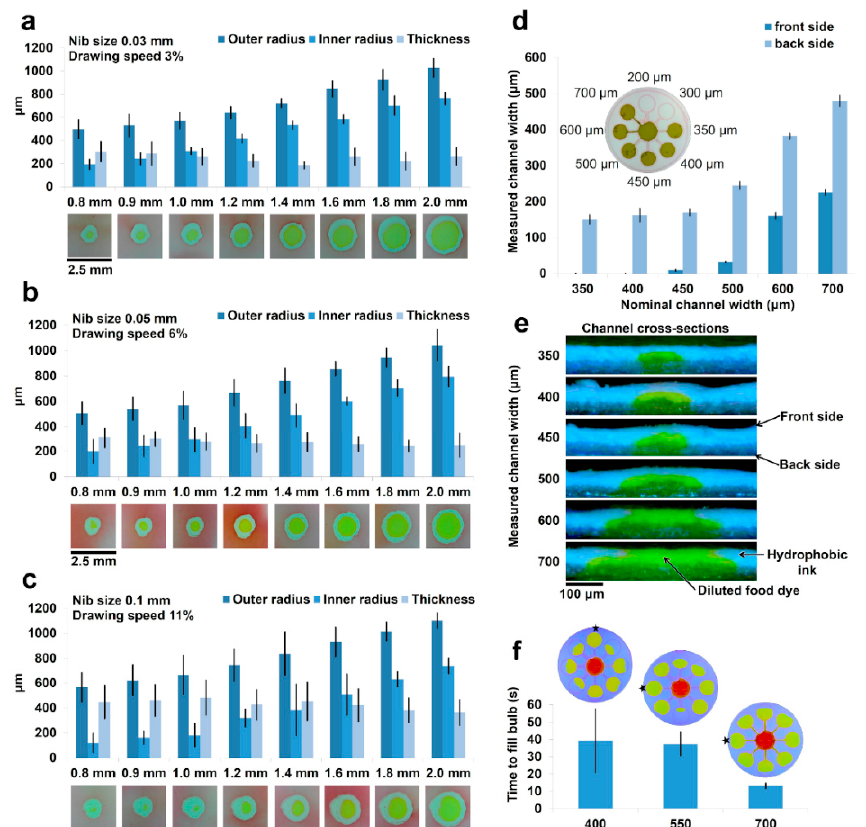
Figure 4. Characterization of high-resolution fabrication of detection zones and channels. ( a ) The resolution of 0.03 mm fiber technical pen on regenerated paper with optimal 3% drawing speed ( N = 9 and the error bar shows the standard deviation); ( b ) the resolution of 0.05 mm fiber technical pen on regenerated paper with optimal 6% drawing speed ( N = 9 and the error bar shows the standard deviation); ( c ) the resolution of 0.1 mm fiber technical pen on regenerated paper with optimal 11% drawing speed ( N = 9 and the error bar shows the standard deviation). The results measured using MATLAB script at 8 angles around each reaction area across reaction areas. ( d ) The graph of the measured microfluidic flow channel width versus the plotted channel width ( N = 8 and the error bar shows the standard deviation). The channels are plotted using the 0.1 fiber technical pen with 11% drawing speed and the channel widths are measured in ten equidistant locations using ImageJ software across three test repeats. ( e ) The cross-sectional image taken of each channel. The channels are filled with yellow food dye to clarify channel vs. barrier. ( f ) The average time to fill bulb for each corresponding equal channel test ( N = 8 and the error bar shows the standard deviation). The color-altered images above the chart display the flow state as the first bulb was completely filled (star marks first bulb to fill).